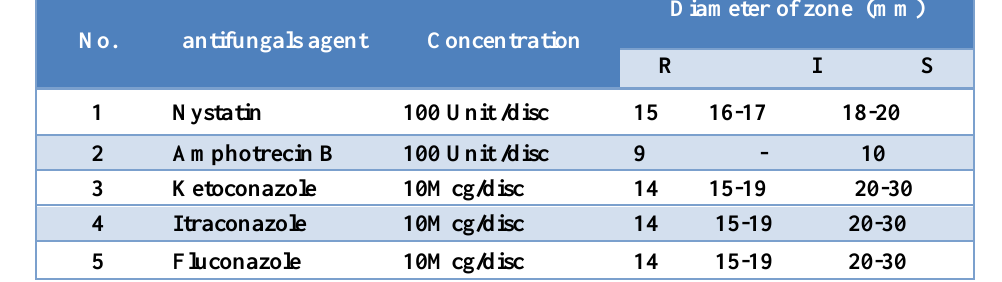
Table 1: The antifungals discs use with their remarks No. antifungals